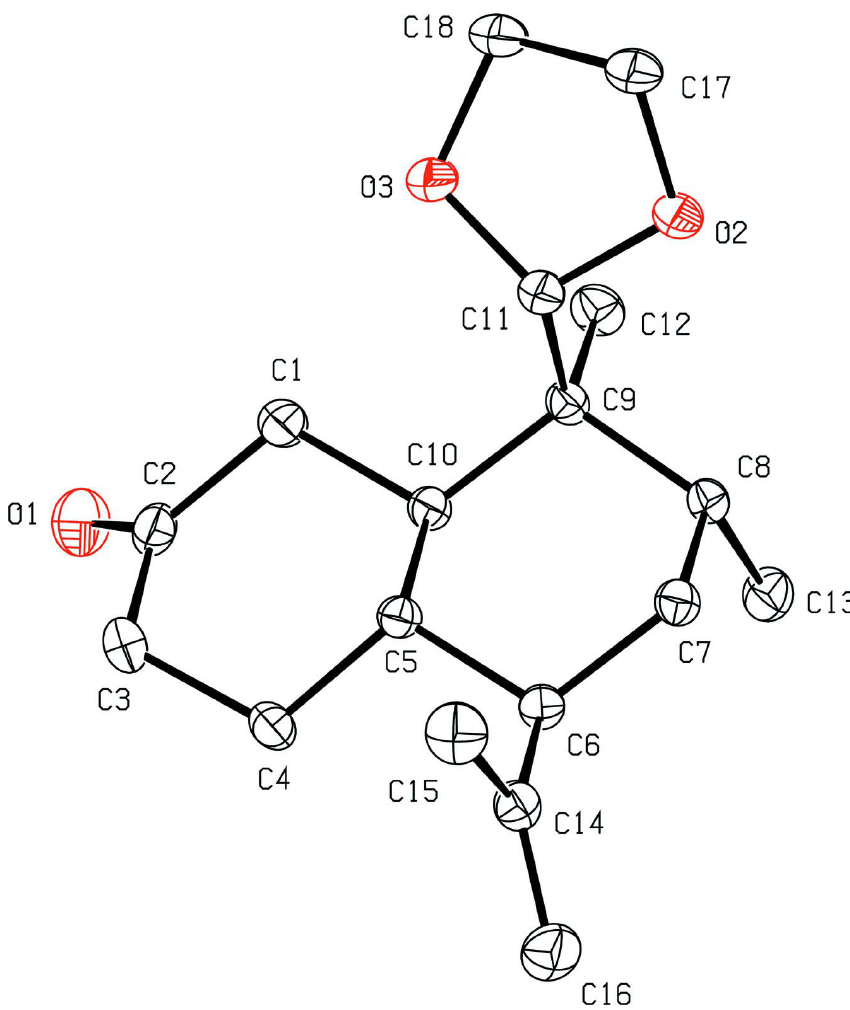
Displacement ellipsoid plot (50% probability level) of the asymmetric unit of the title compound at 150 K. H atoms are omitted for